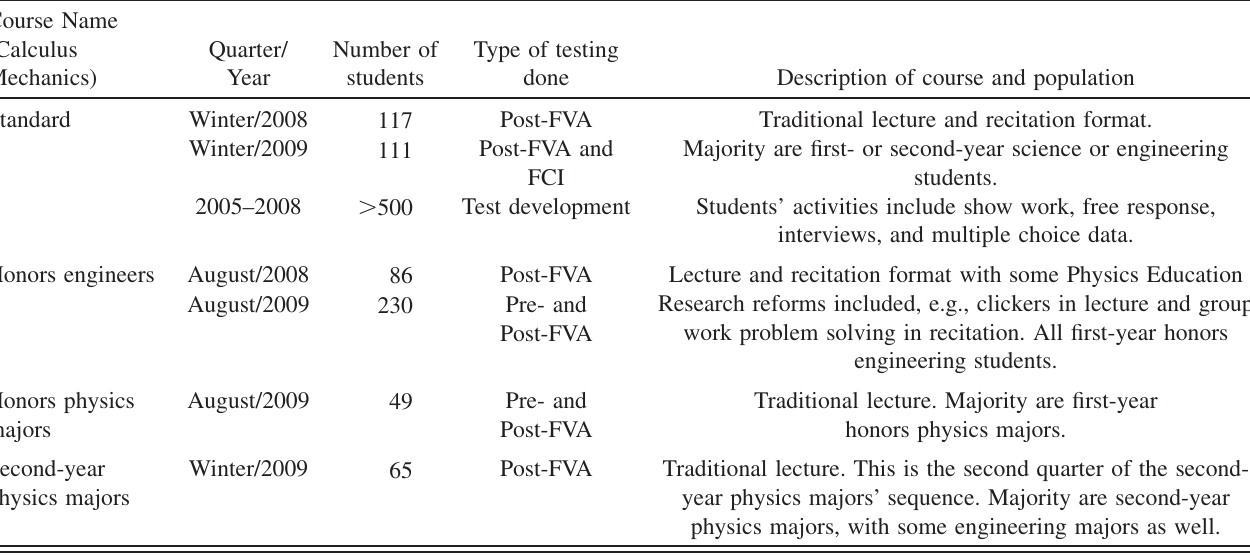
TABLE IV. Outline of test administration and description of courses and